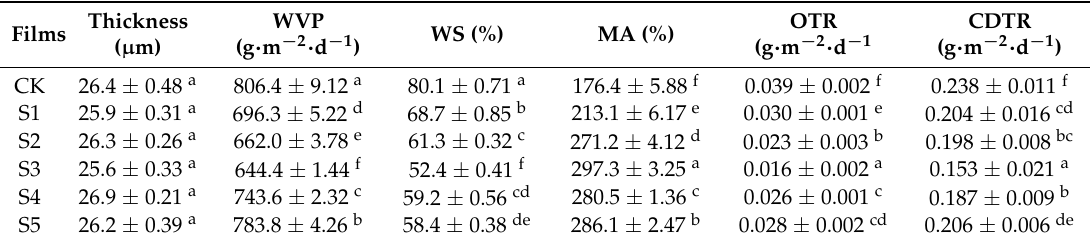
Table 2. Thickness, water vapor permeability (WVP), water solubility (WS), moisture absorption (MA), oxygen transmission rate (OTR), and carbon dioxide transmission rate (CDTR) of